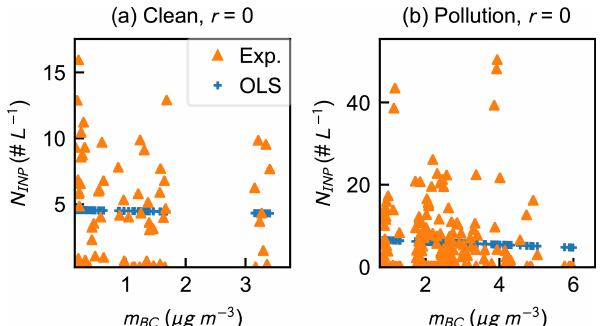
Figure 10. Correlations between m BC and N INP during (a) clean and (b) heavy pollution periods. The r above each panel is Pearson’s correlation coefficient. Blue markers indicate the predicted N INP using fitted linear regression